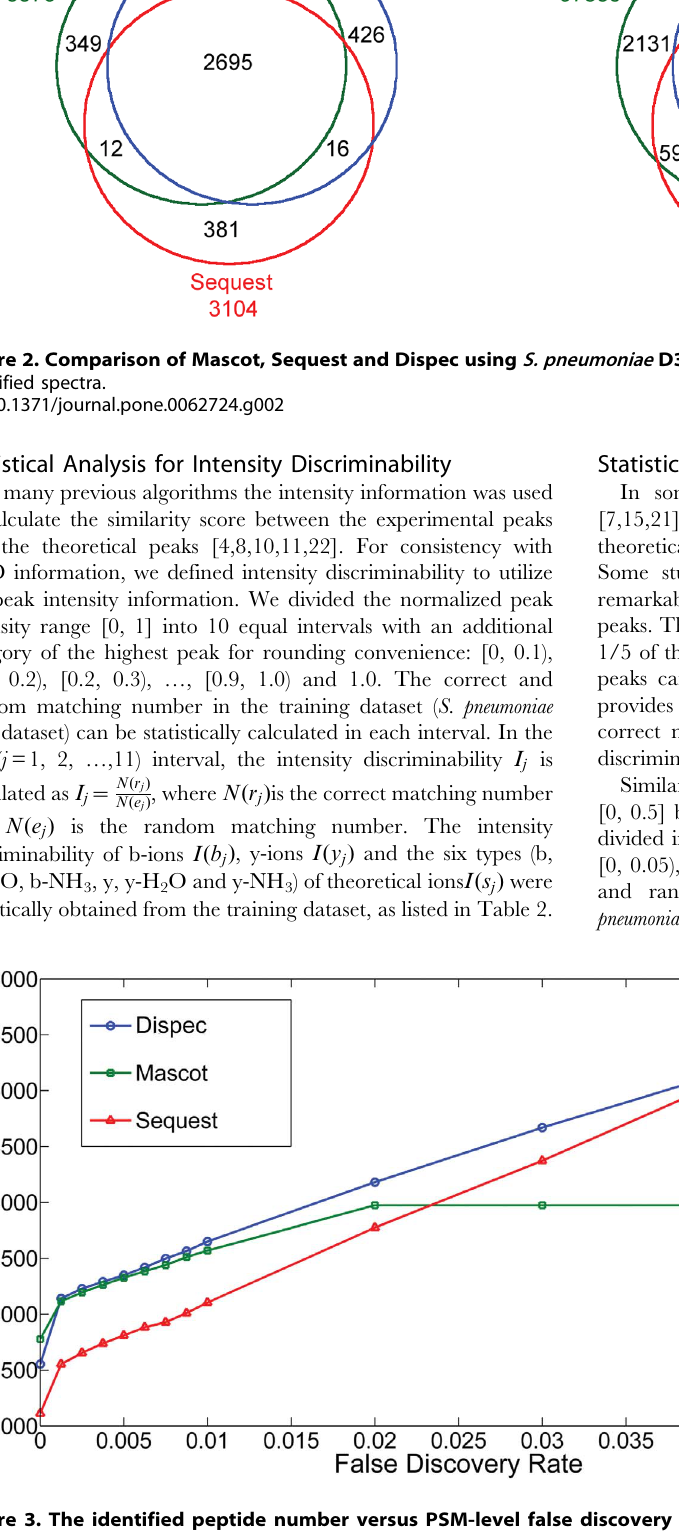
Figure 3. The identified peptide number versus PSM-level false discovery rate (PSM-level FDR) for Dispec, Mascot and Sequest within the PSM-level FDR range 0% ,